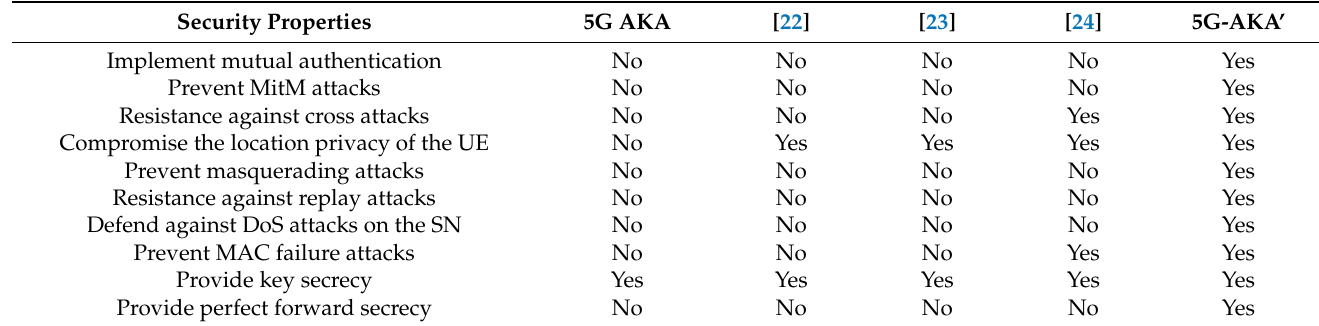
Table 2. The comparative analysis of security properties between the 5G-AKA’ protocol and some recently improved 5G AKA protocols